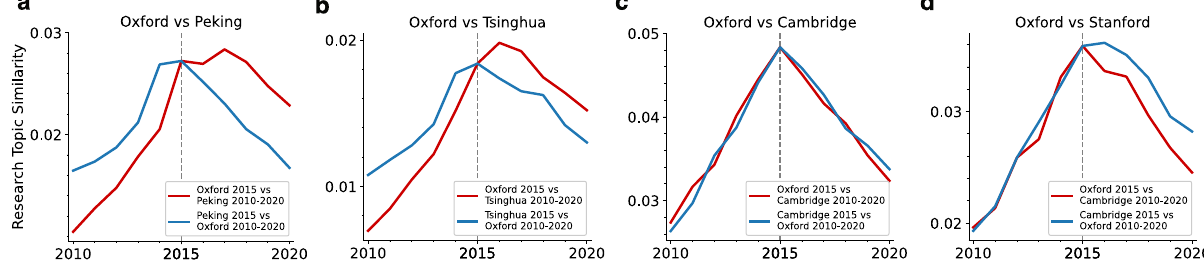
Figure 2. Detailed analysis of topic progress in universities: ( a – d ) University-level research topic comparison between Oxford and Peking University ( a ), Tsinghua University ( b ), Cambridge ( c ), or Stanford ( d ). The red lines indicate cosine similarities between T in 2015 in the Oxford and T in 2010-2020 in other universities. Blue lines indicate the opposite